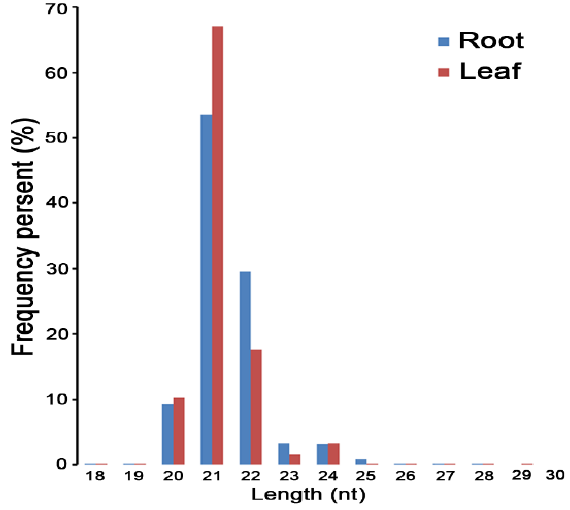
Figure 4. Length distribution of miRNAs identified from Brassica juncea .